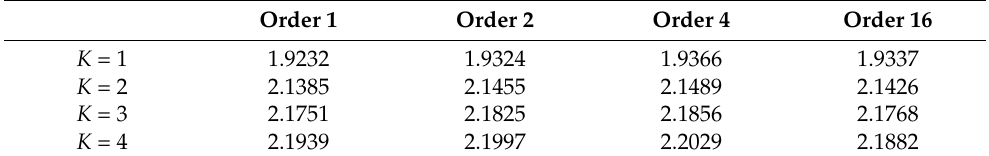
Table 1. BIC values for B-spline regression mixtures for different values of K and orders. The maximum BIC value is obtained for K = 4 and order 4.